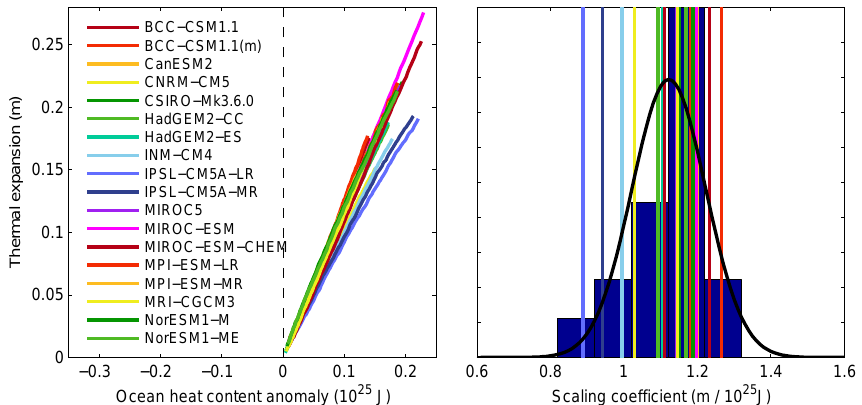
Fig. 1. Left panel: global mean thermal expansion vs. ocean heat content anomaly with CMIP5 GCMs (reference period: 1980–1999) for the 2000–2100 period under the RCP 4.5 scenario (except for MIROC-ESM whose RCP 6.0 scenario is shown); right panel: corresponding regression coefficients (vertical bars) with their empirical frequency distribution and the fitted Gaussian distribution (see Sect.